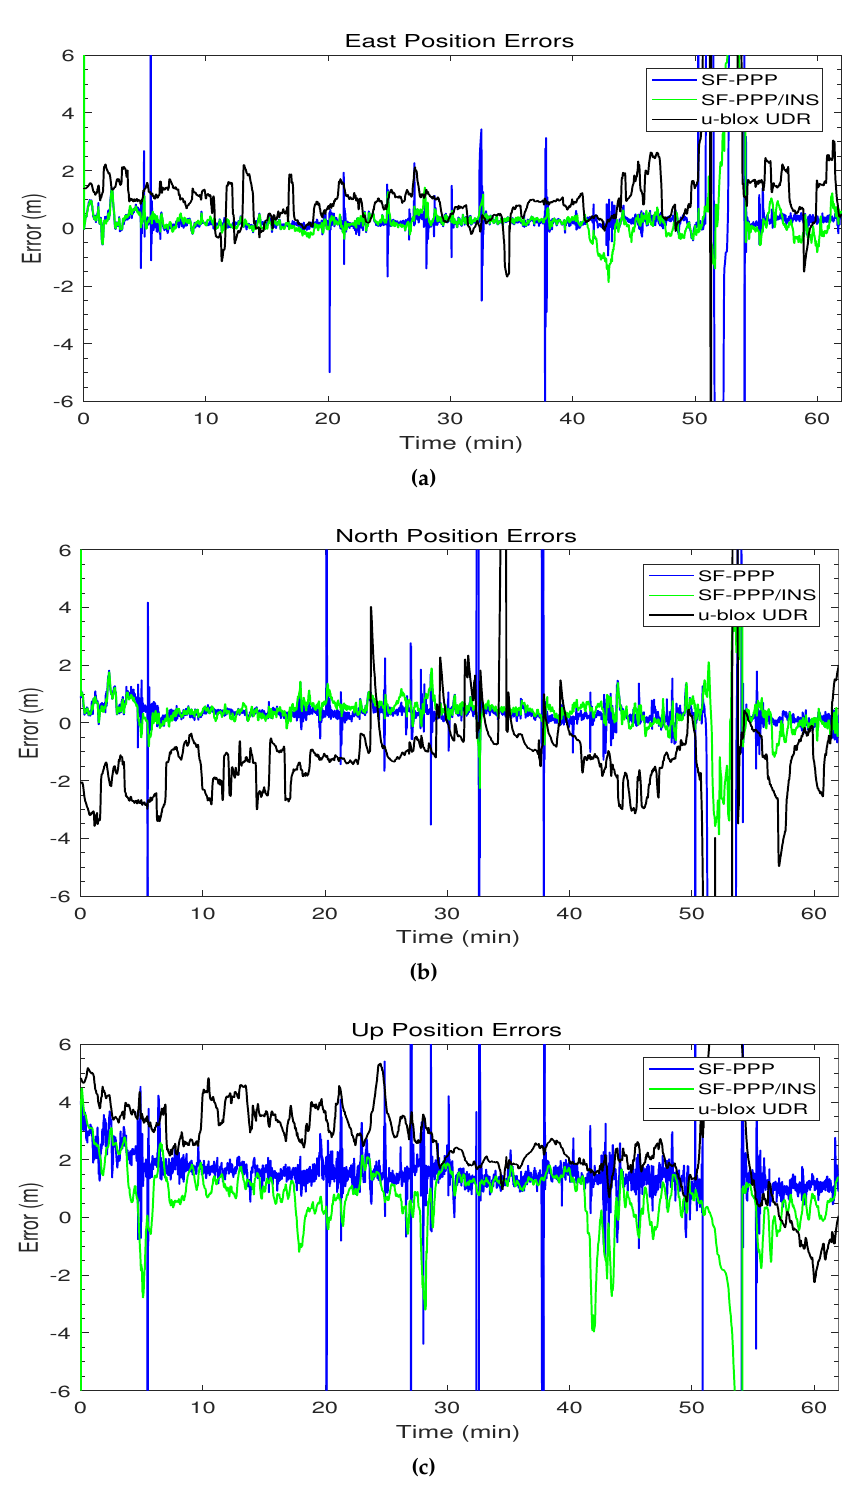
Figure 11. The second trajectory position errors versus time in ( a ) east, ( b ) north, and ( c ) up